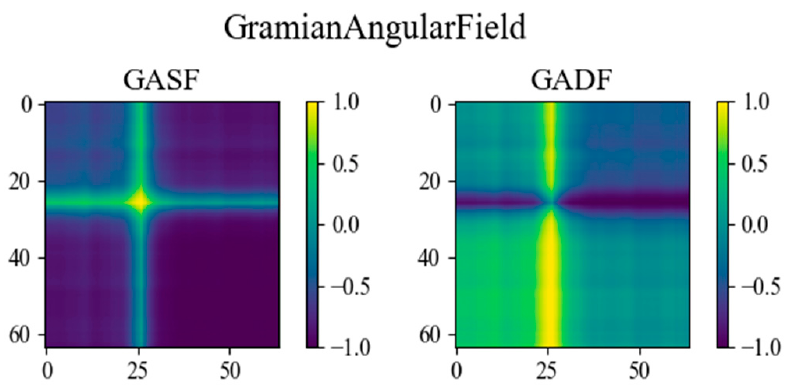
Figure 6. Single-channel 2D sensor image.